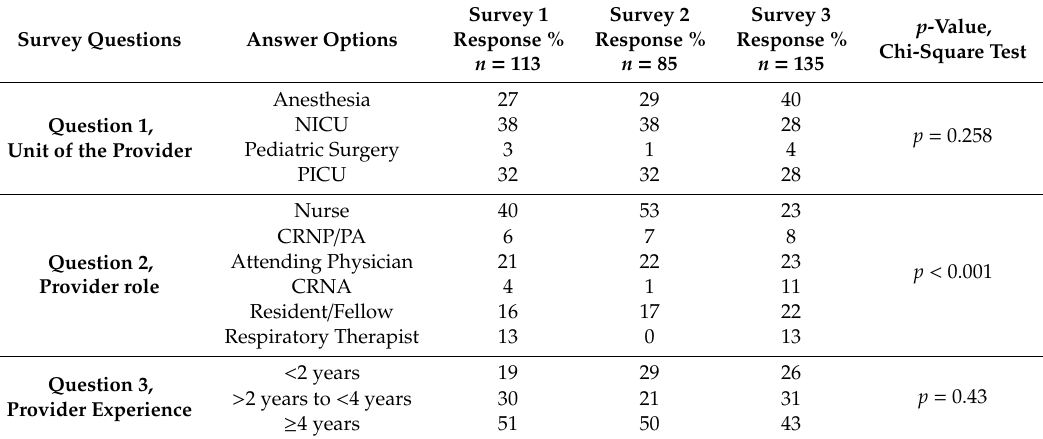
Table 1. Demographic data for provider responses to survey questions 1, 2 and 3, NICU = Neonatal